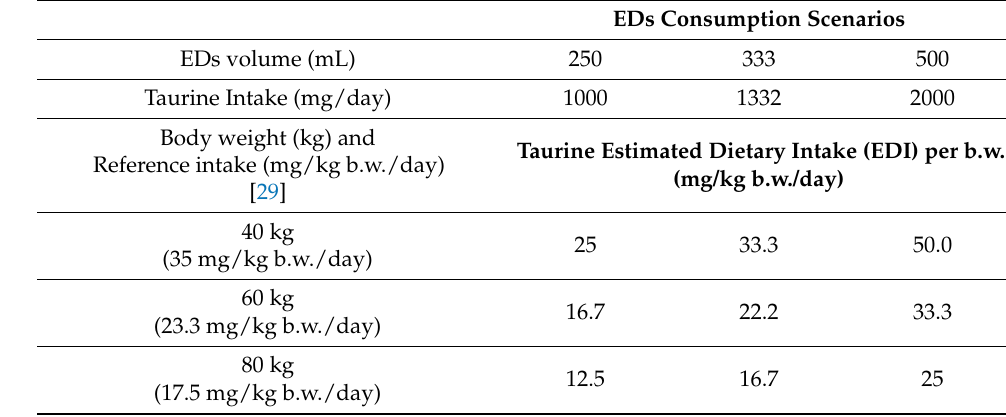
Table 4. 4000 mg taurine/l EDs: exposure assessment